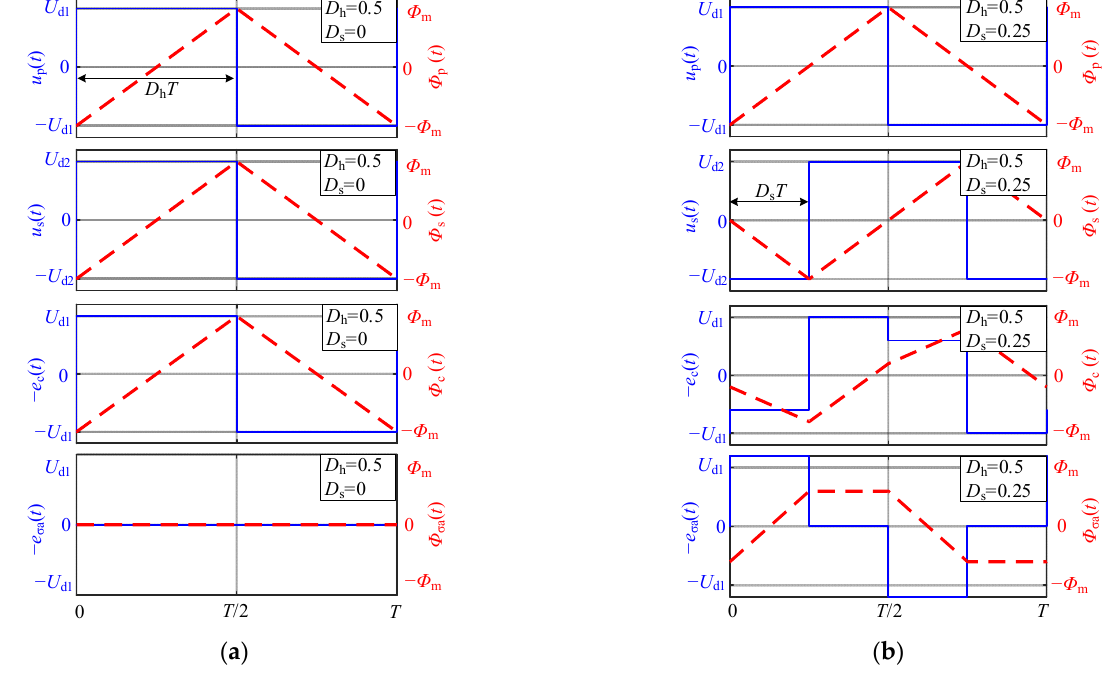
Figure 5. Voltage, induced electromotive force, and flux waveforms of CW ELII MFT under typical DAB excitation. ( a ) D h = 0.5, D s = 0; ( b ) D h = 0.5, D s = 0.25.